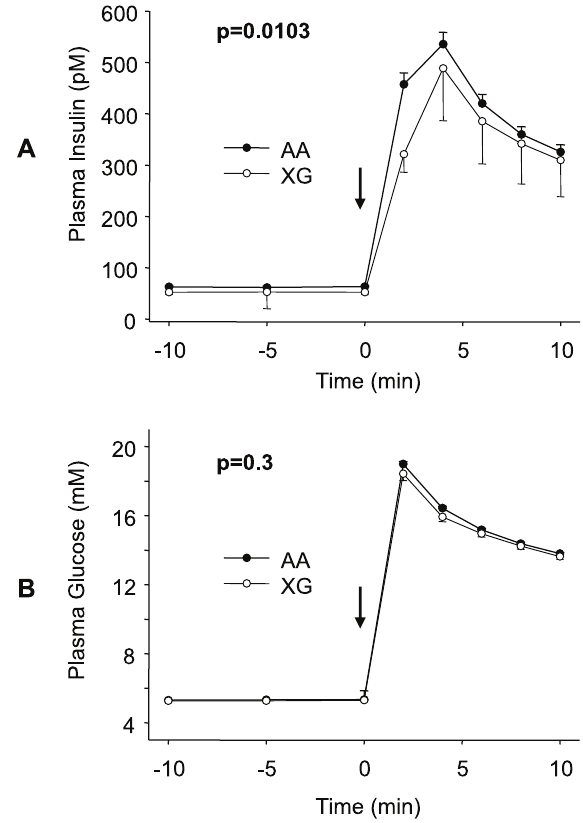
Figure 2. Metabolic data in carriers of the PTBP1 SNP rs11085226 during the IVGTT. Shown are plasma insulin (A) and glucose (B) concentrations. Data are given as means + / 2 SEM. P-values for AUC of the ten minutes following glucose injection adjusted for gender, age, BMI, and clamp-derived insulin sensitivity are given. Arrows mark the time-point of glucose infusion. Black circles: homozygous carriers of the major allele; white circles: heterozygous and homozygous carrier of the minor